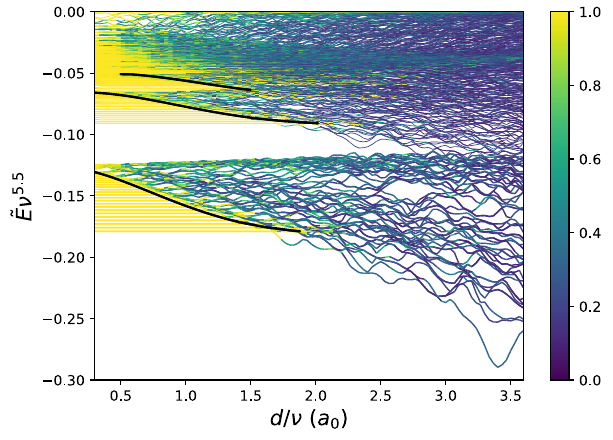
FIG. 5. Spectra for a ν ¼ 30 2D Rydberg composite as a function of lattice spacing. The line color shows P each state as defined by Eq. (11). The black line marks the border between homogeneous and inhomogeneous regimes [see Eq.